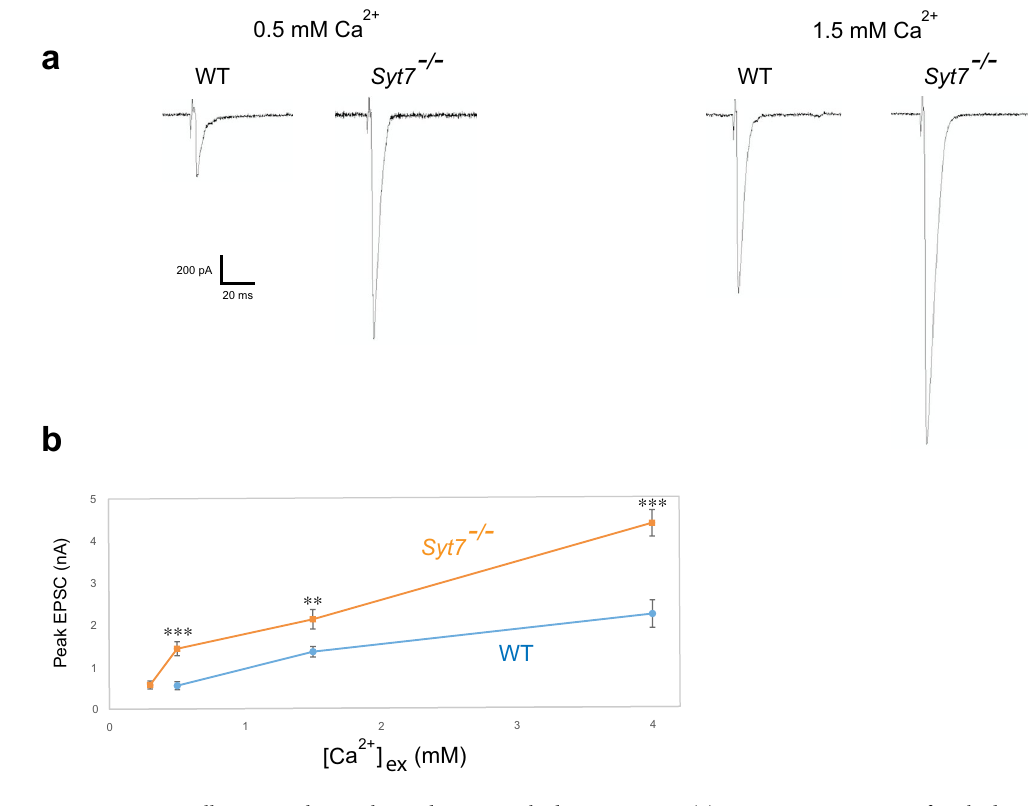
Figure 2. Syt7 null mutants show enhanced nerve-evoked transmission. ( a ) Representative traces of evoked synaptic currents in wild type (WT) and Syt7 −/− at 0.5 mM Ca 2+ and 1.5 mM Ca 2+ . ( b ) Ca 2+ dependence of peak evoked synaptic currents (EPSC). WT and Syt7 −/− were analyzed at each Ca 2+ concentration with Student’s t test, and significant difference between the two groups was found at 0.5 mM Ca 2+ (***P < 0.001), 1.5 mM Ca 2+ (**P < 0.01) and 4 mM Ca 2+ (***P < 0.001). WT was not quantified at 0.3 mM Ca 2+ due to the high probability of failures. The numbers of recorded cells analyzed for each genotype: (WT) 0.5 mM, 11; 1.5 mM, 11; 4 mM, 8 ( Syt7 −/− ) 0.3 mM, 19; 0.5 mM, 15; 1.5 mM, 20; 4 mM, 9. Error bars are SEM.